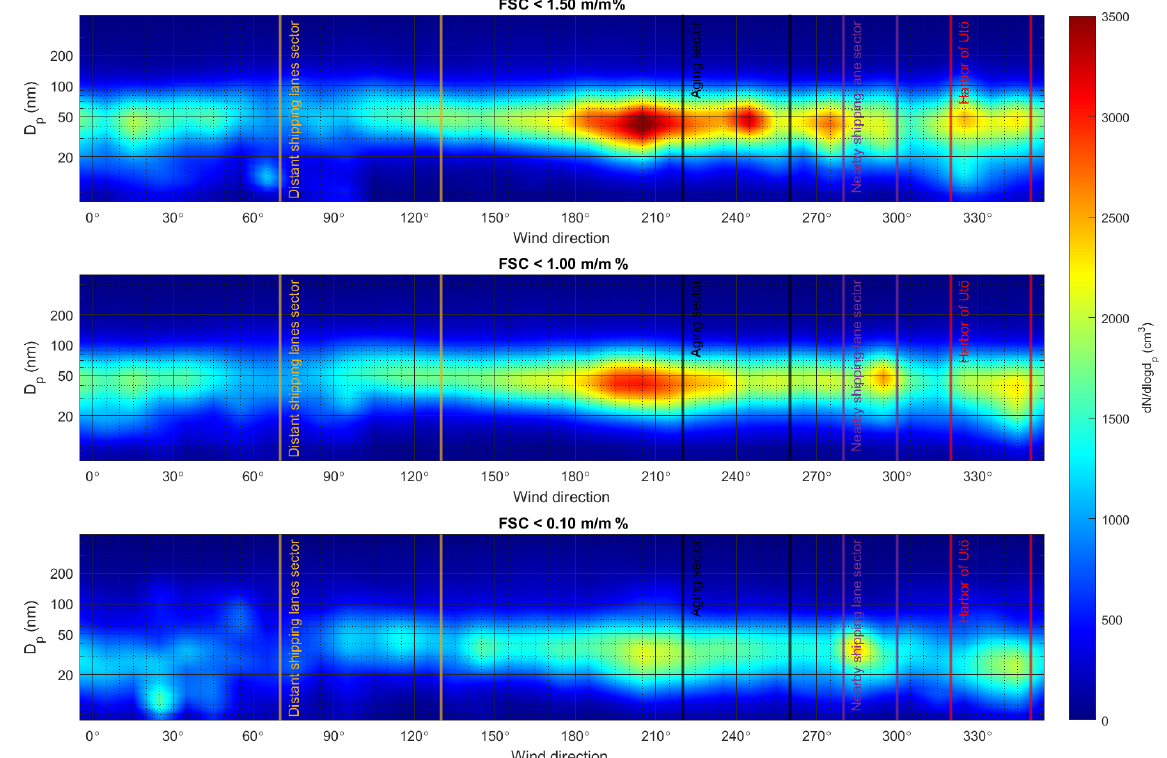
Figure 6. Plume particle number size distributions (NSDpl; averaged for wind directions) for different fuel sulfur content (FSC) restrictions. Wind directions are shown on the x axis, particle mobility diameters ( D p ) are shown on the y axis, and normalized particle number concen- tration (d N/ dlog d p ) are shown using colors. The distant shipping lanes sector, aging sector, nearby shipping lane sector, and harbor of Utö are marked using pairs of vertical